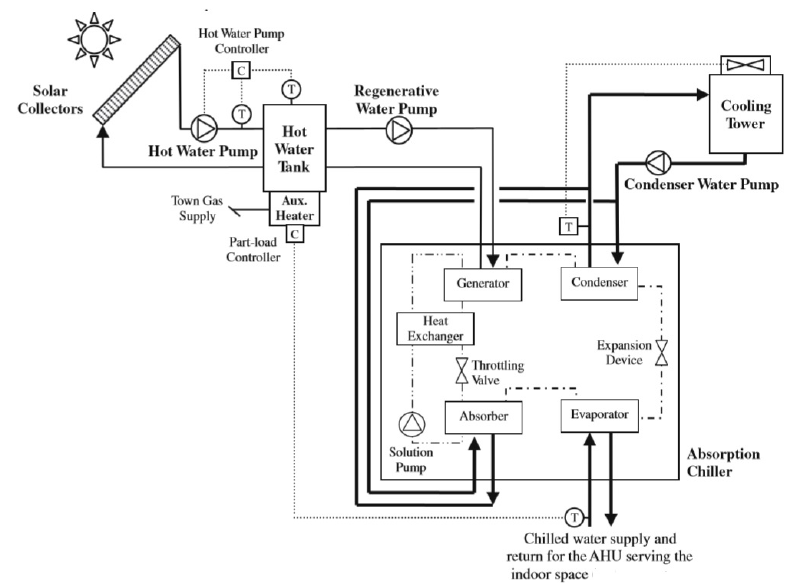
Figure 8. Schematic diagram of solar absorption cooling